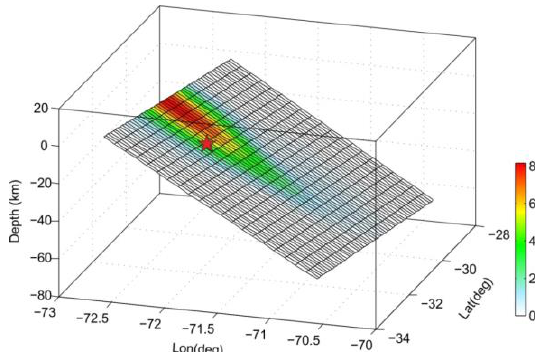
Figure 6. Coseismic slip distribution model derived from this inversion displaying in 3D frame. Red star symbol indicates the Global CMT epicenter.